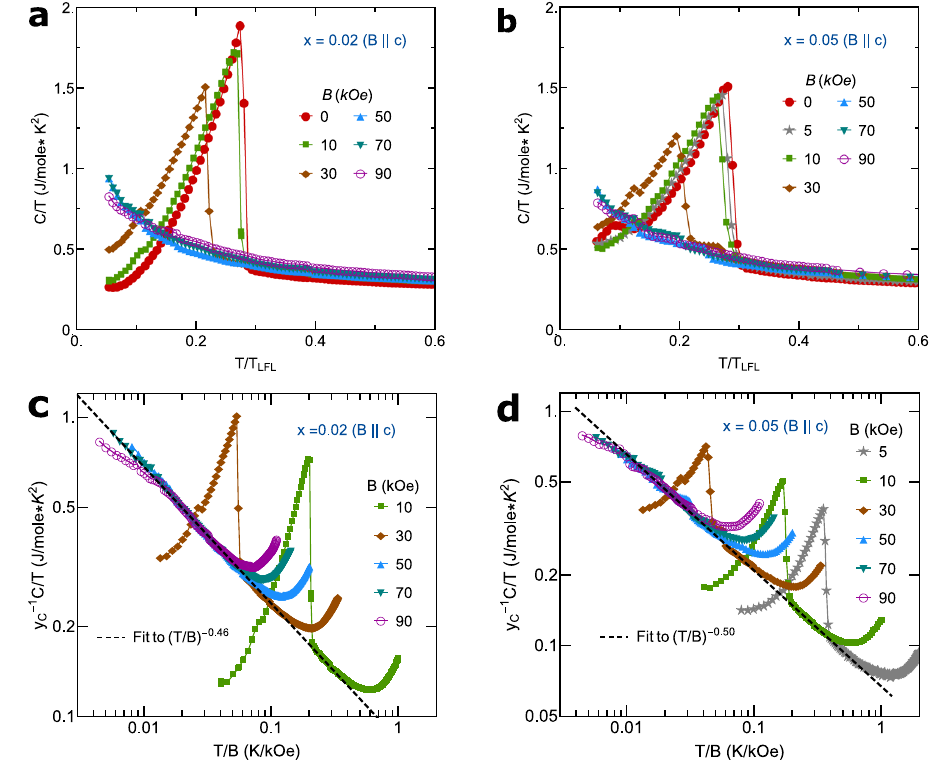
y C in c and d represents a non-universal scaling parameter, obeying y (cid:2) 1 C = T Þ = Φ ð T = B Þ with Φ being a power-law function C ð